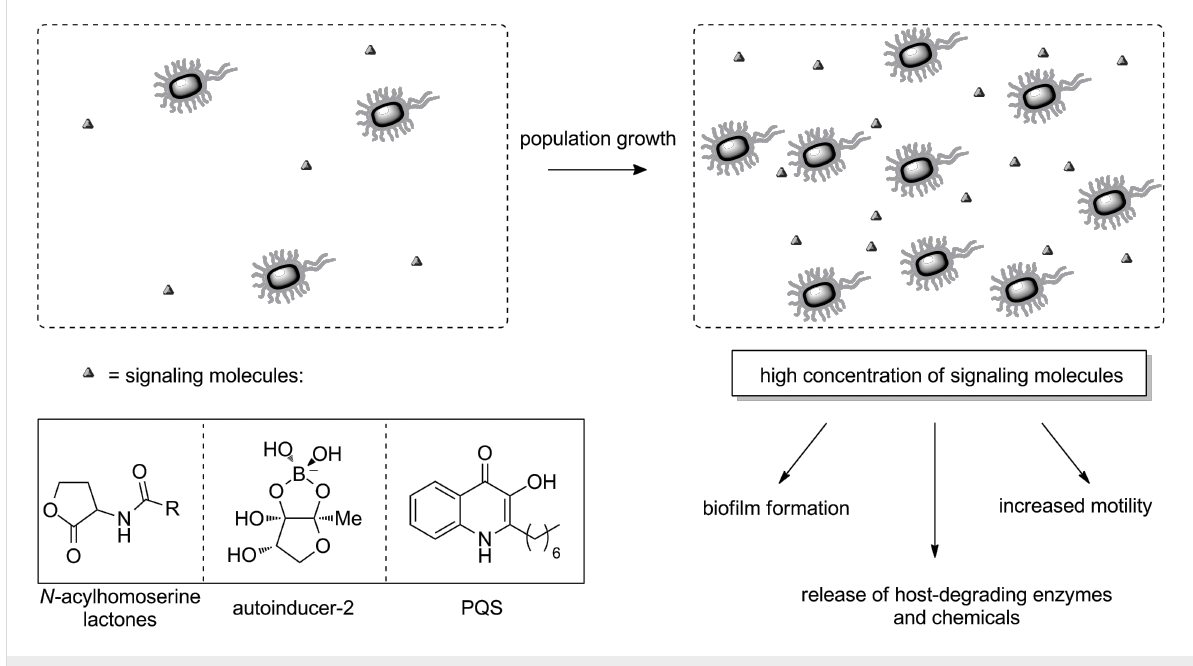
Figure 5: The mechanism of quorum sensing and representative signaling